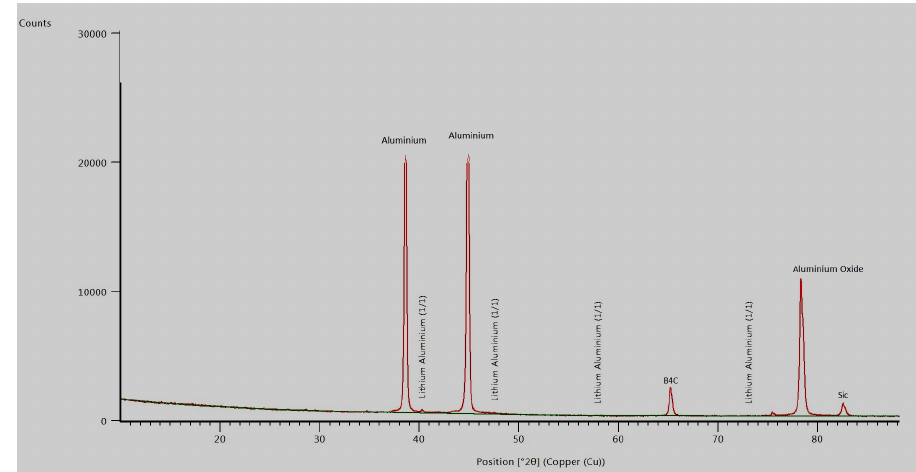
Figure 3. X – Ray Diffraction Analysis Pattern of 5% of Reinforcement. (SiC, graphite, B4C, Al2O3)